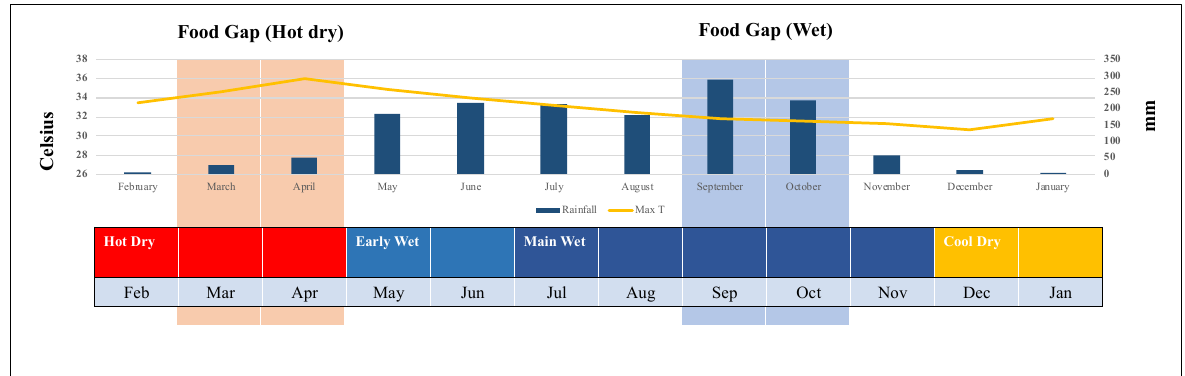
Figure 2. Potential for Optimizing Across Temporal Food Gaps a